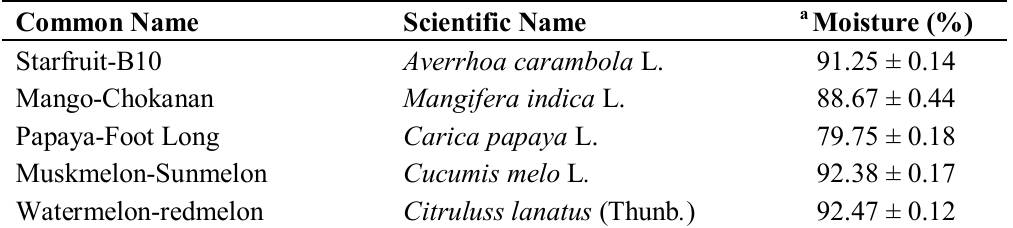
Table 1. Common and scientific names and moisture content of tropical